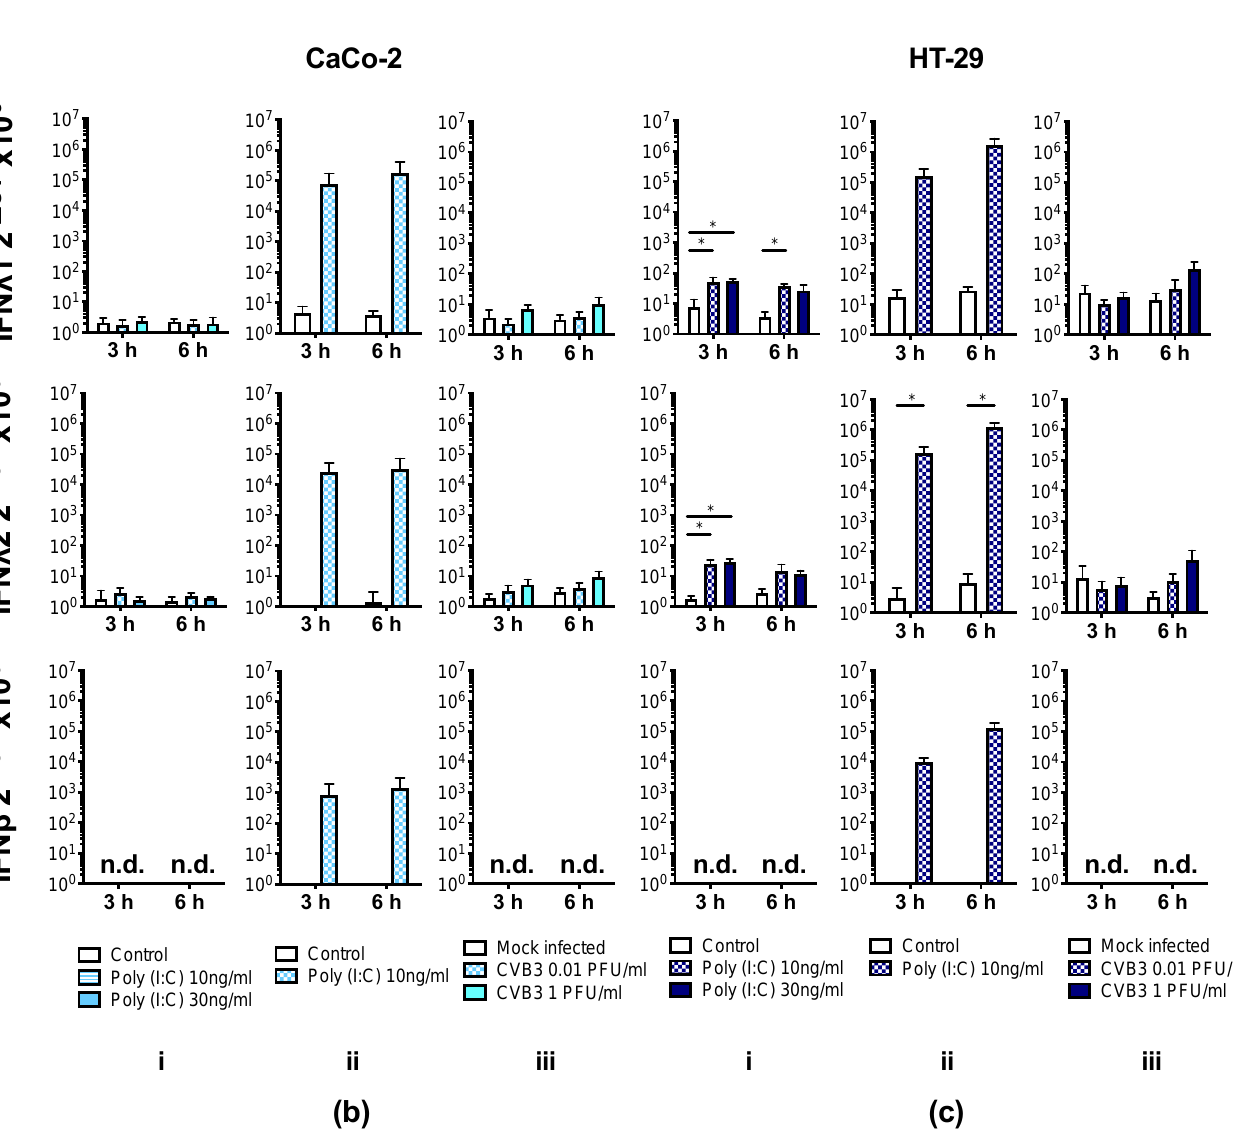
Figure 4. Polyinosinic:polycytidylic acid (poly (I:C)) transfection, but not Coxsackievirus B3 (CVB3) infection, induces the expression of interferons (IFNs) in intestinal epithelial cells (IECs). ( a ) The expression of the pattern recognition receptors toll-like receptor 3 (TLR3), melanoma differentiation-associated protein 5 (MDA-5), and retinoic acid-inducible gene 1 (RIG-I) were confirmed in CaCo-2 and HT-29 cells at the mRNA level by real-time PCR. ( b ) CaCo-2 or ( c ) HT-29 cells were treated with 10 ng/mL or 30 ng/mL poly (I:C) (i) or transfected with 10 ng/mL poly (I:C) (ii) or infected with 0.01 or 1 plaque forming units (PFU)/mL CVB3 (iii) for 3 h or 6 h. The expression of the type I or III IFNs at the mRNA level was measured by real-time PCR. Data presented as the mean ± SD from at least three independent experiments per cell line (* p < 0.05 and ** p <0.01; Student’s t -test with Welch’s correction or one-way ANOVA).